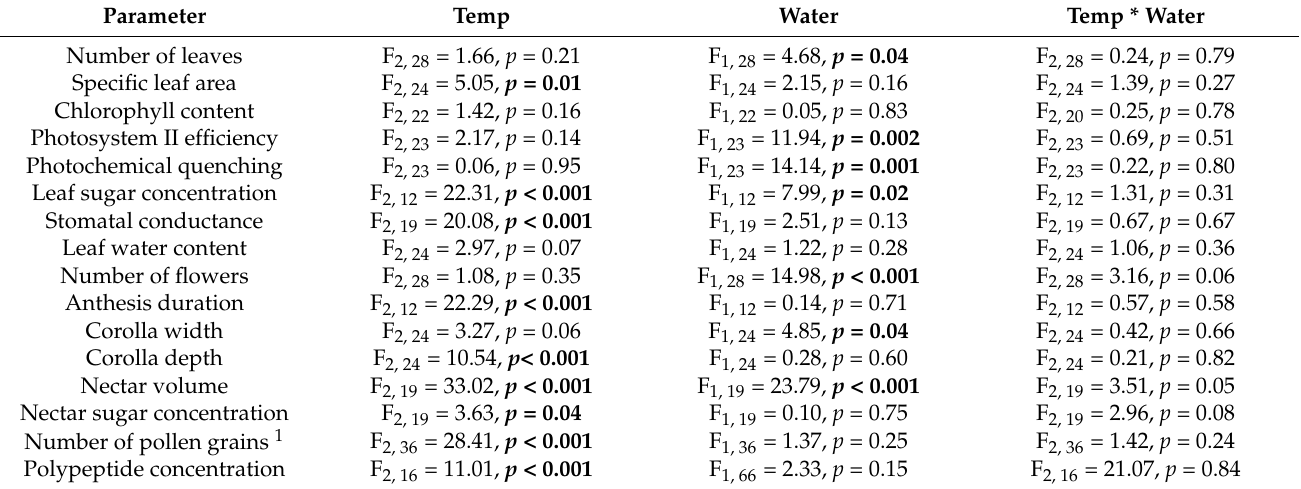
Table 1. Statistical results of the effects of an increase in temperature (Temp), water stress (Water) and their interaction (Temp * Water) on vegetative, physiological and floral traits and resources of Impatiens glandulifera. Significant differences are indicated in